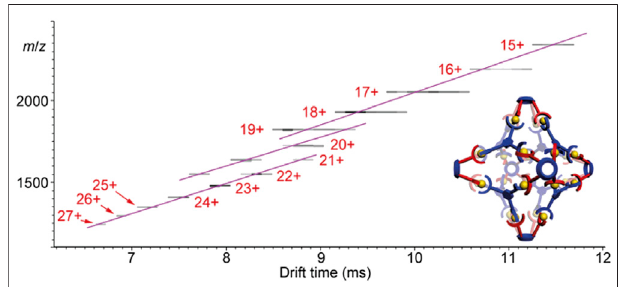
FIGURE10| Observationoftwodistinctcubicstarstructuresseeninion mobility dependent on assembly charge. These two structures are represented by the two different families of peaks (pink lines) observed with a smaller transitionary family observed in between (He et al.,